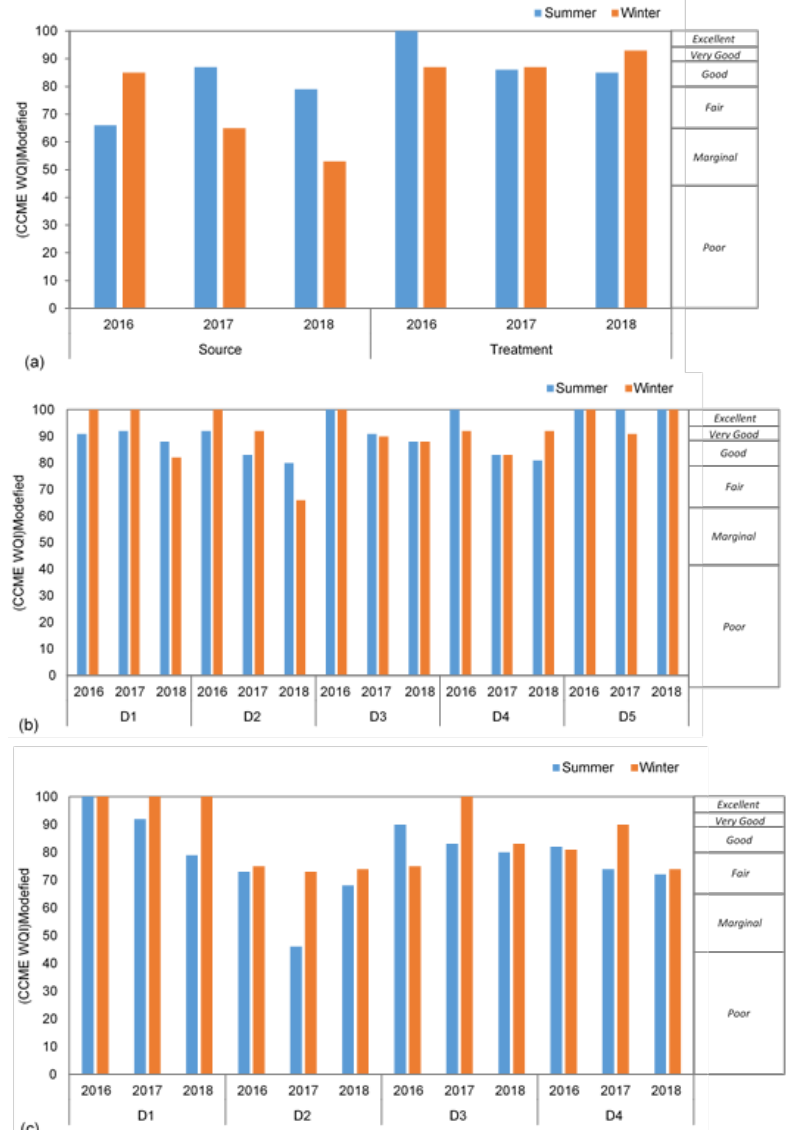
Figure 4. Modified CCME WQI in WSS-I, ( a ) Source water and water treatment plant, ( b ) zone 1, ( c ) zone 2.